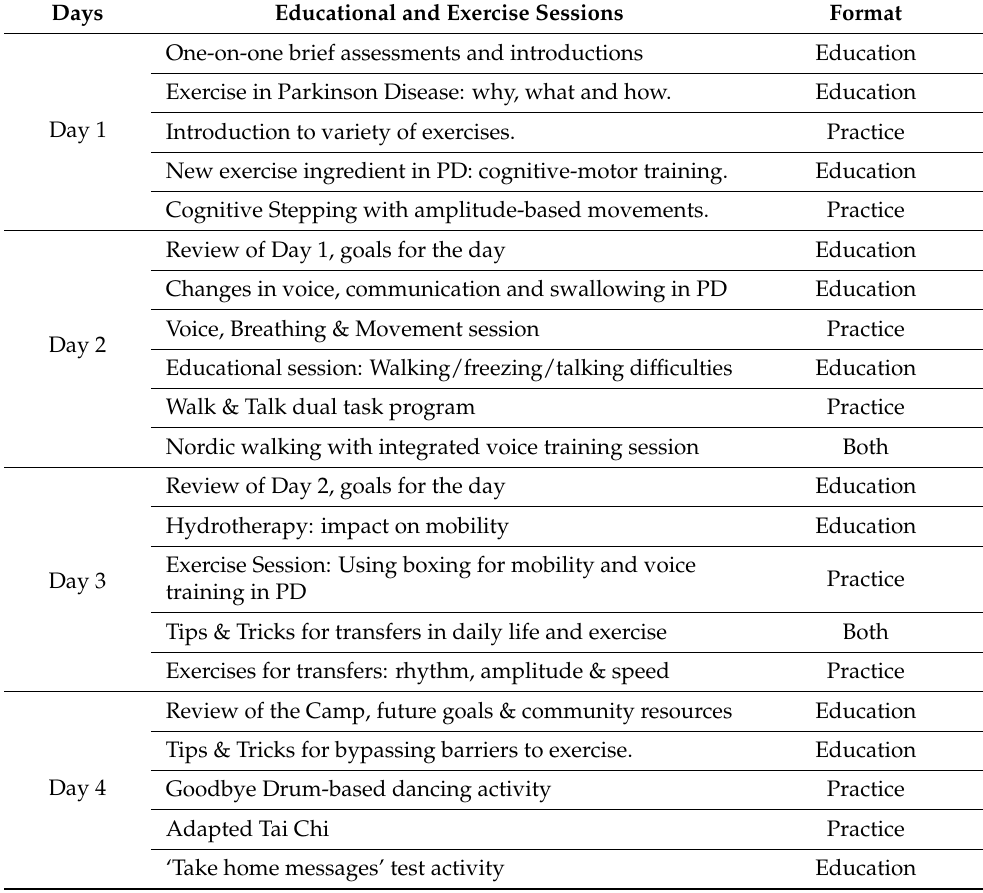
Table 2. Description of the boot camp educational and exercise sessions’